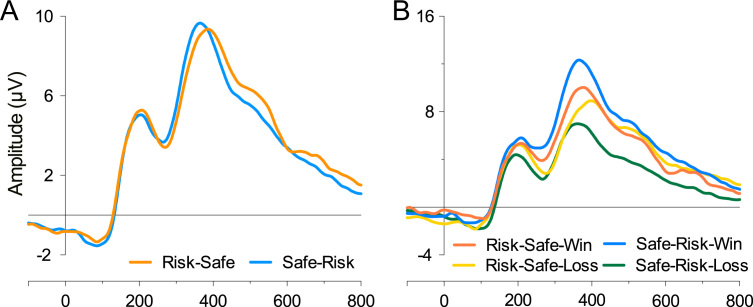
Switch direction and outcome related activity. (A) ERPs at FCz showed marginally significant peak-to-peak FRN effect with greater negativity for Riskt−1Safet responses relative to Safet−1Riskt, however, there was no statistically reliable Switch Direction×Outcome interaction. (B) Abscissa represents time in milliseconds.